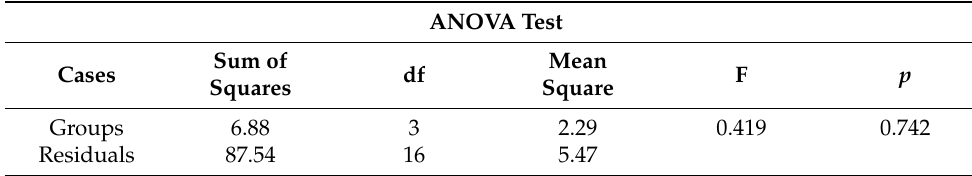
Table 3. ANOVA of the local blood perfusion difference, compared with a baseline after ischemic induction perfusion in each group submitted to stroke model (G2, G3, G4, and G5). ANOVA Test Sum of Squares